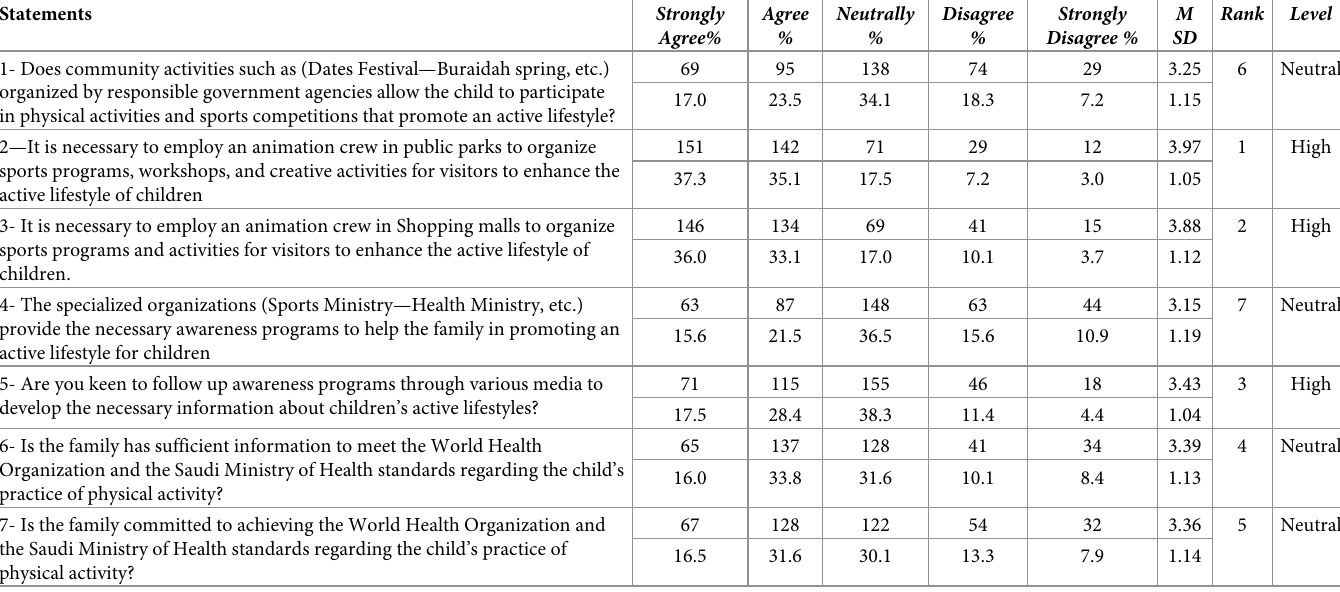
Table 3. Descriptive statistics of the quality of community activities and awareness programs to promote an active lifestyle.